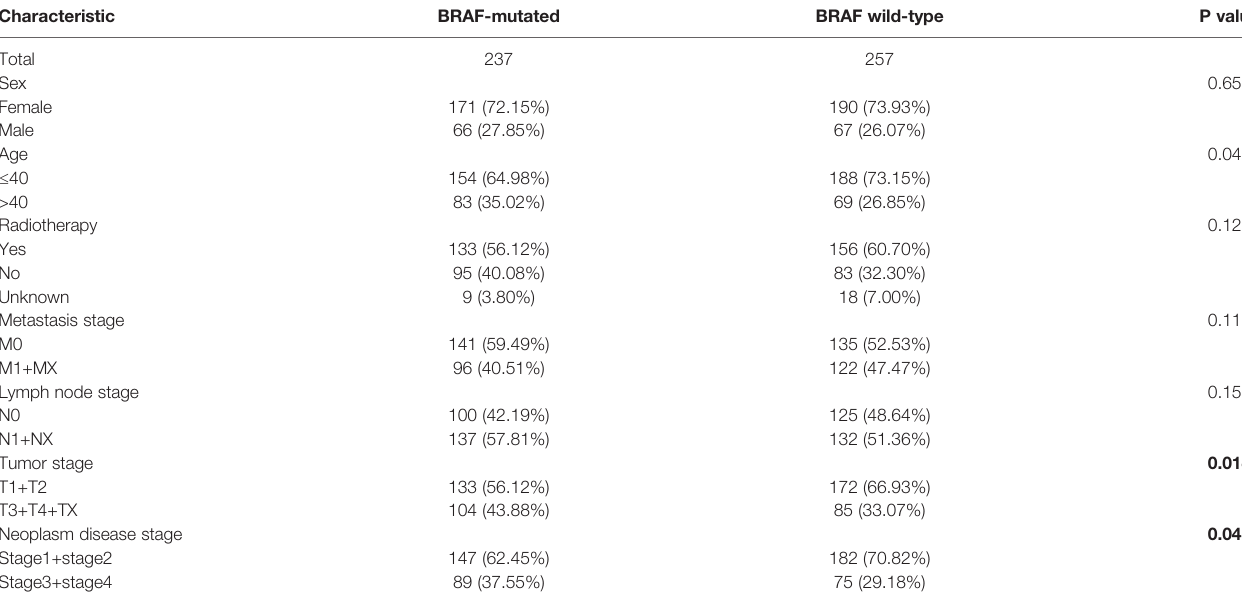
Bold values indicate statistically signi fi cant